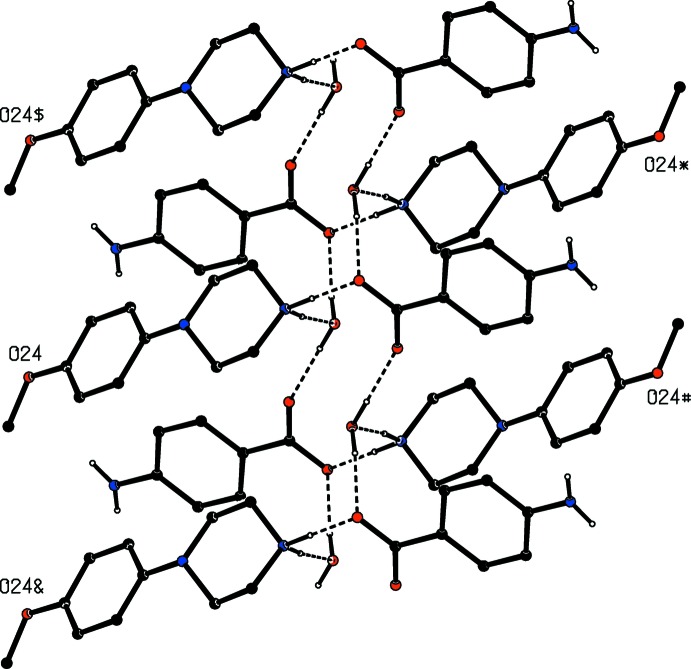
Part of the crystal structure of compound (IV) showing the formation of a hydrogen-bonded chain of rings parallel to [100]. Hydrogen bonds are drawn as dashed lines and, for the sake of clarity, the unit-cell outline and the H atoms bonded to C atoms have been omitted. The atoms marked with an asterisk (*), a hash (#), a dollar sign ($) or an ampersand (&) are at the symmetry positions (1 − x, 1 − y, 2 − z), (−x, 1 − y, 2 − z), (1 + x, y, z) and (−1 + x, y, z) respectively.